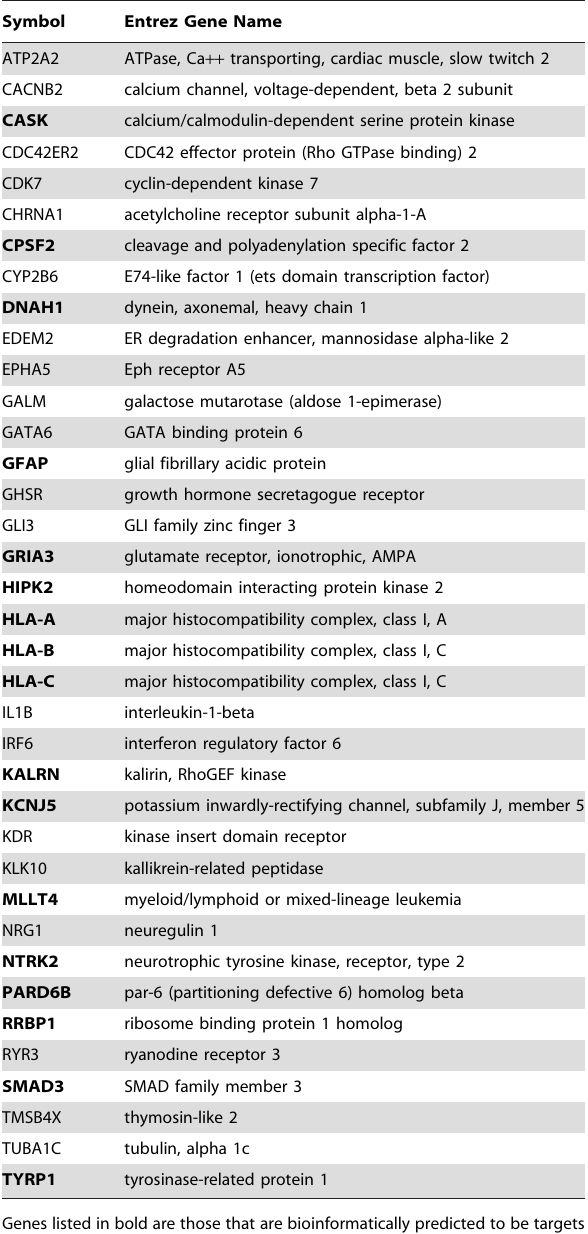
Table 3. Analysis of genes dysregulated by over-expression, or knock-down, in resting EOC 13.31 cells using either miR- 146a mimics or